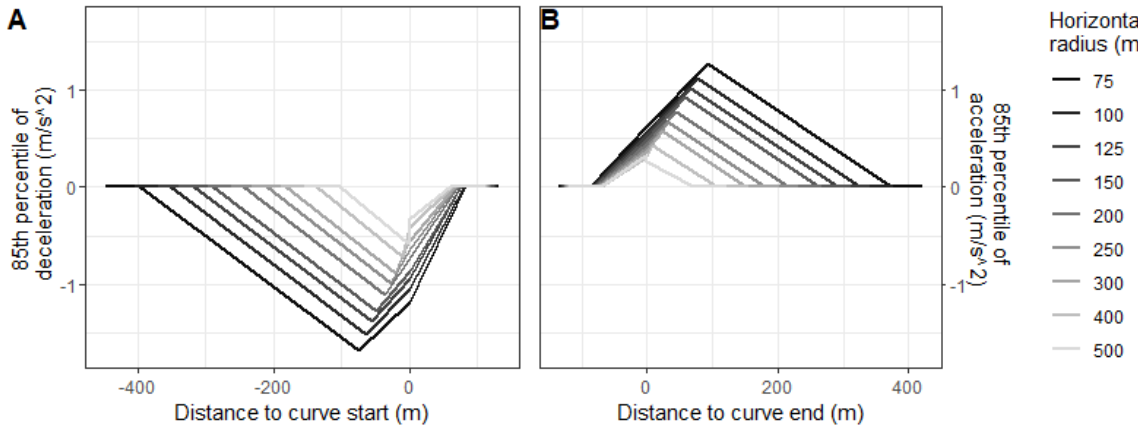
Figure 10. Profiles for the 85 th percentile of deceleration and acceleration on different horizontal radii based on breakpoints and maximum